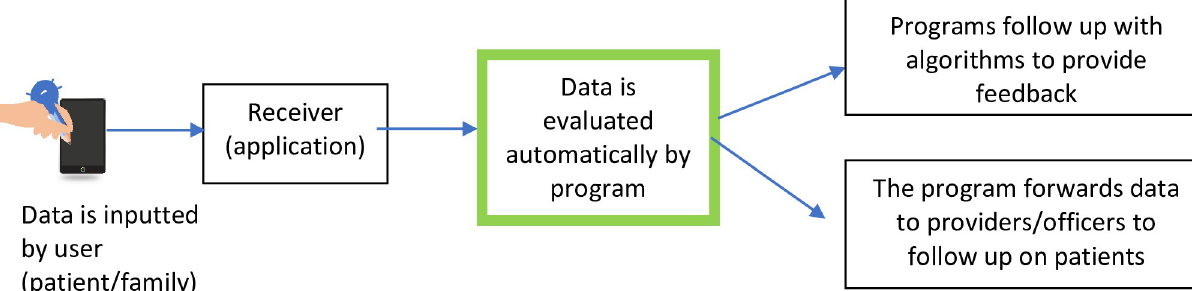
Fig 6. Integration of remote patient monitoring and decision support